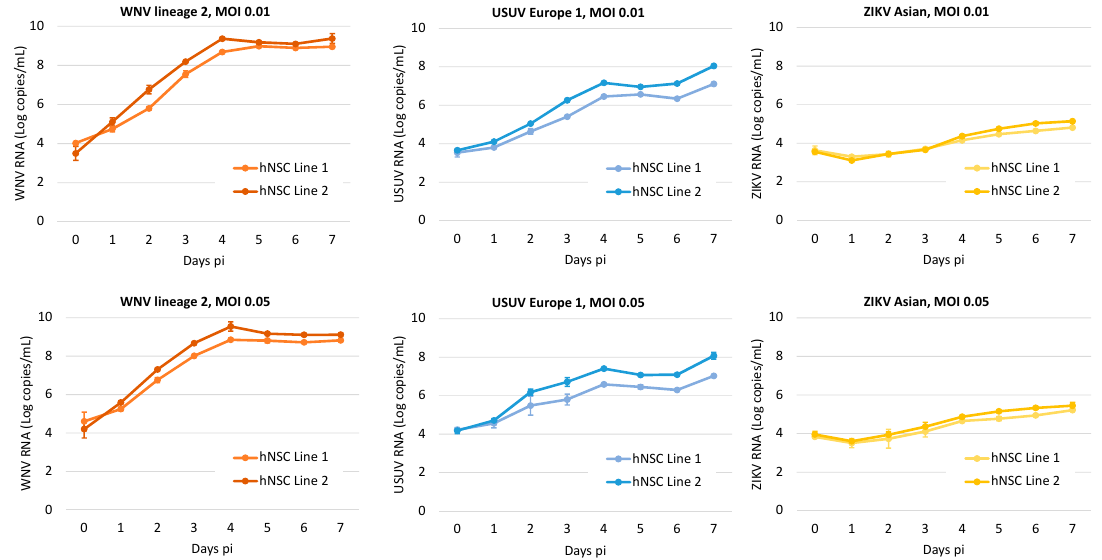
Figure 3. WNV, USUV and ZIKV production kinetics on hiPSC-derived NSCs. Cells were infected with WNV lineage 2, USUV Europe 1 and ZIKV Asian lineage at MOI 0.01, and 0.05 and viral RNA load was measured in cell culture supernatant by qRT-PCR daily, from day 0 to day 7 post infection (pi). Cell growth medium was replaced daily. Viral RNA load is reported as Log copies/mL. Analyses were performed in duplicate and repeated in three independent experiments. Data represent mean values ± SD of all experiments.